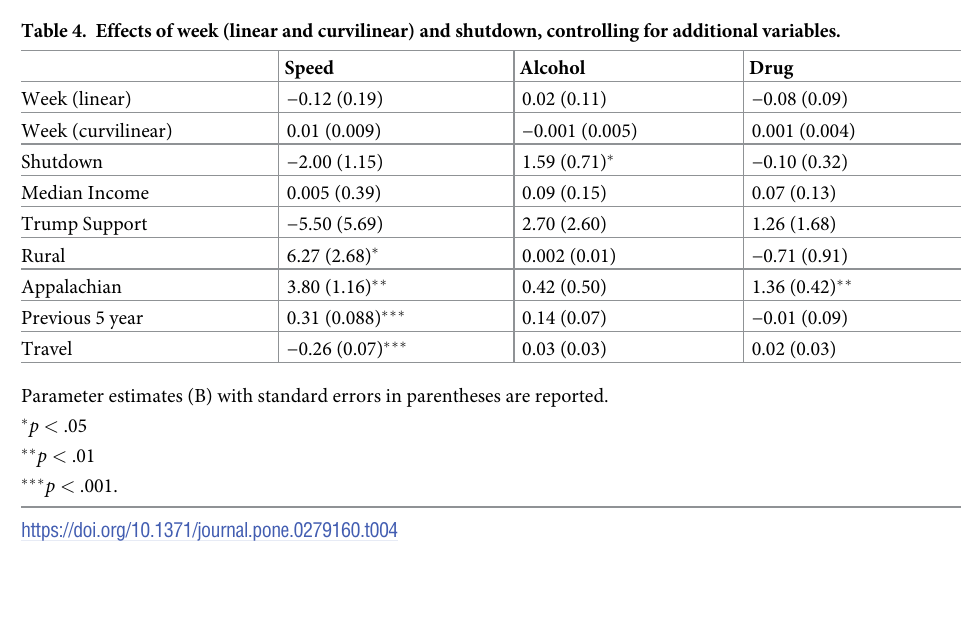
Table 4. Effects of week (linear and curvilinear) and shutdown, controlling for additional variables. Speed Alcohol Drug Week (linear) − 0.12 (0.19)